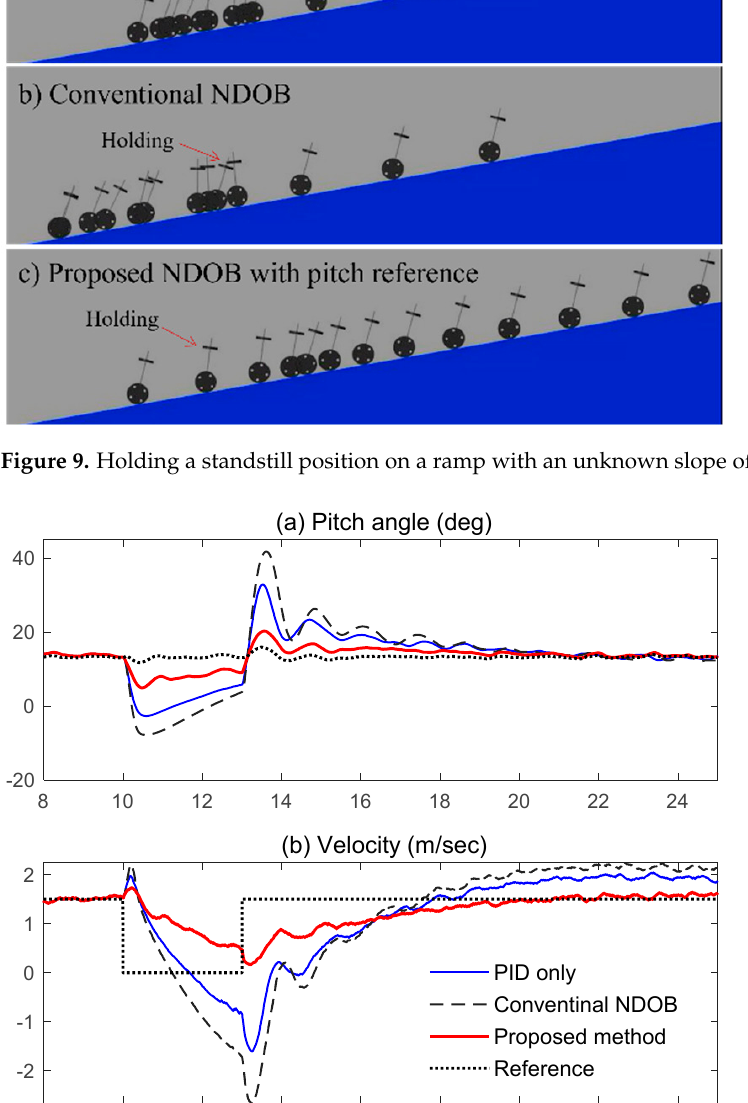
Figure 10. Holding a standstill position on a ramp with an unknown slope of 10 degrees. The pitch references for PID and conventional NDOB were zero.